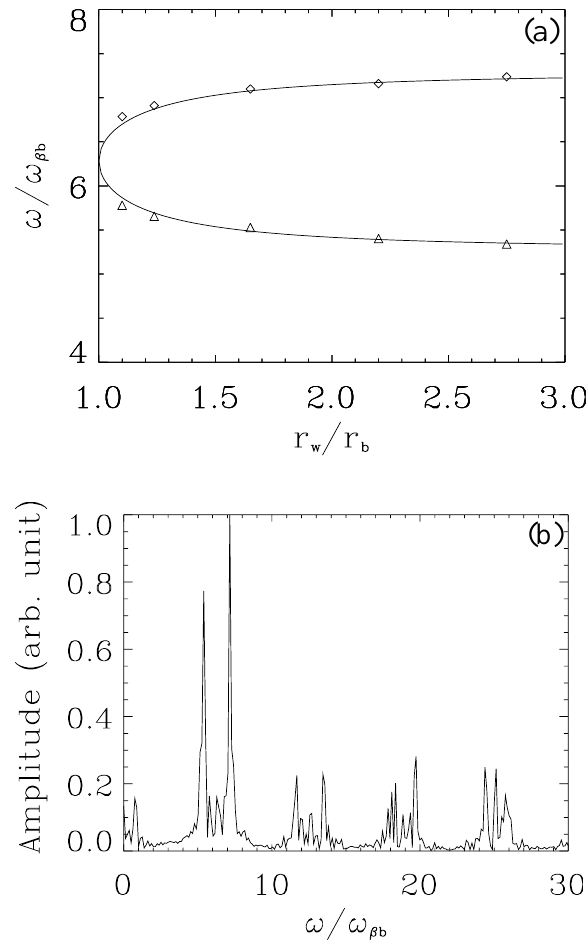
FIG. 2. Excitation of the l (cid:1) 1 surface mode in a uniform- density ion beam, including (a) a plot of the normalized os- cillation frequency v (cid:3) v b b versus r w (cid:3) r b and (b) a plot of the frequency spectrum for r w (cid:3) r b (cid:1) 2.2